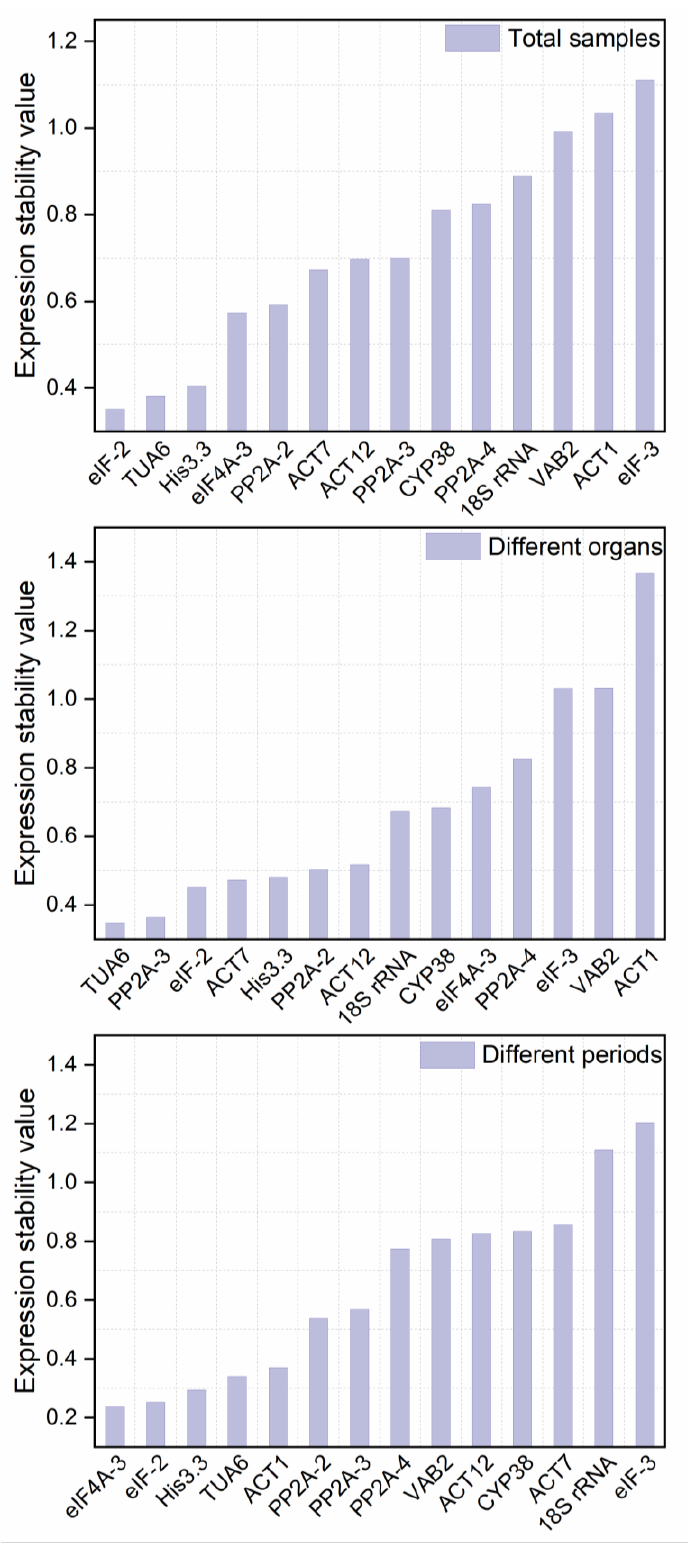
Figure 5. Expression stability of 14 reference genes in P. vulgaris analyzed by NormFinder.